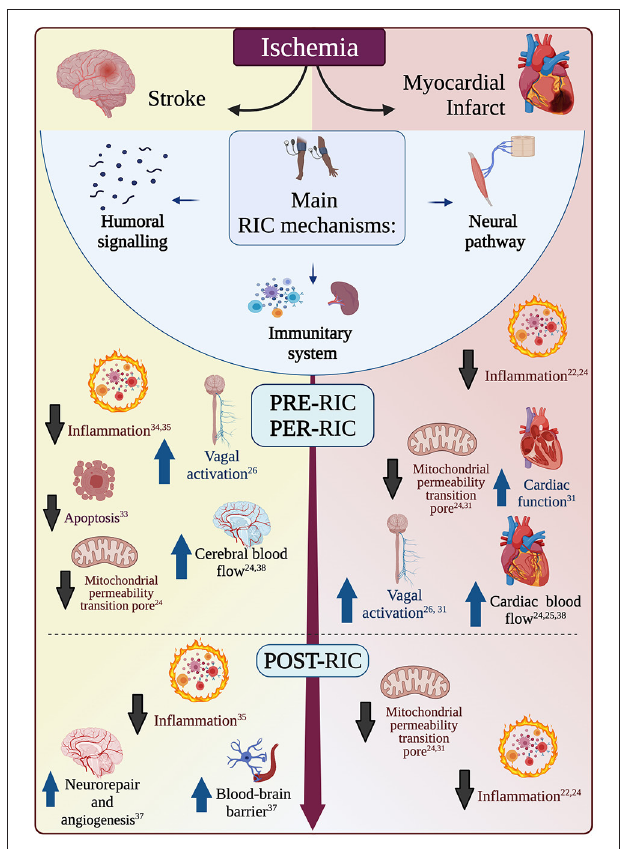
FIGURE 1 | Main mechanisms of remote ischemic conditioning (RIC). RIC can be performed before (pre-RIC), during (per-RIC), or after (post-RIC) an ischemic event (ischemic stroke or myocardial infarction). RIC effects are mostly mediated by humoral signaling, neural pathways, or modulation of systemic immune system. These different pathways generate many effects that have different importance in the setting of myocardial infarction (red, on the right) or ischemic stroke (yellow, on the left), while some effects are likely of similar importance in both conditions (in the white area in the middle). While the same mechanisms may have different importance before, during or after an ischemic event, there is not enough literature to attribute each mechanism to a certain phase only. Upward blue arrows indicated increase and enhancement, while downward black arrows indicate reduction and